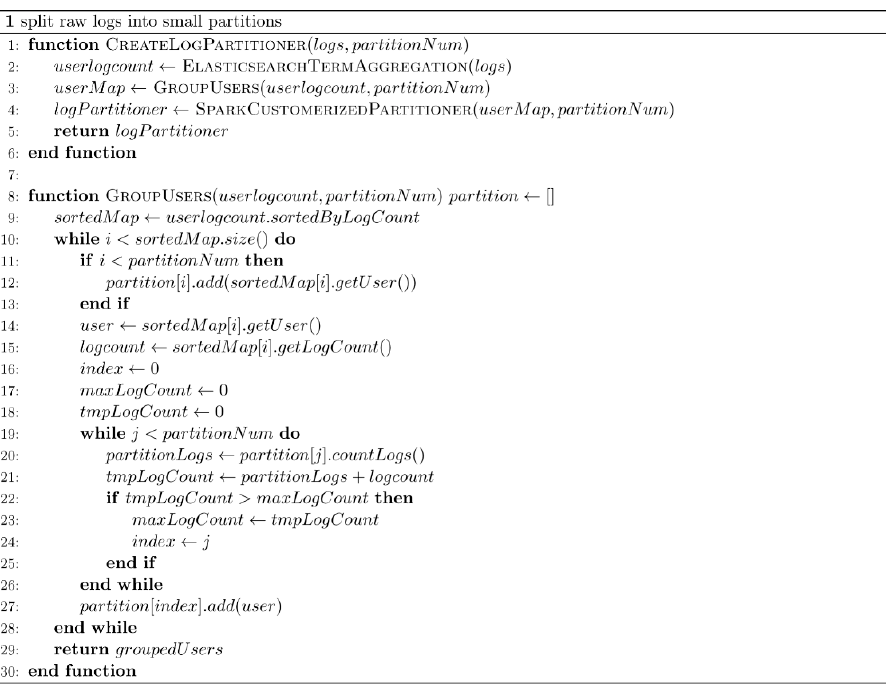
Figure 9. The testbeds for the proposed framework.